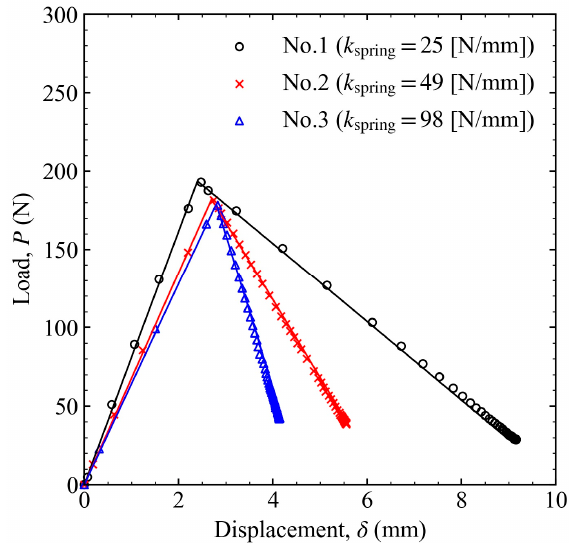
Figure 4. Relationship between load and displacement when the spring constant was changed to 25, 49, and 98 N/m.